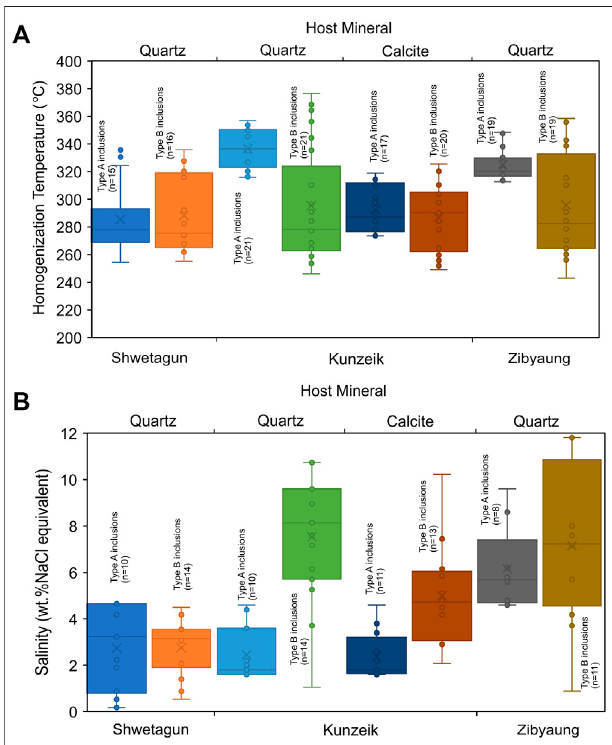
FIGURE 13 | Box and whisker plots showing (A) total homogenization temperatures and (B) calculated salinity values in two and three phase fl uid inclusions from Shwetagun, Kunzeik, and Zibyaung. Abbreviations: n (cid:1) number of fl uid inclusions.